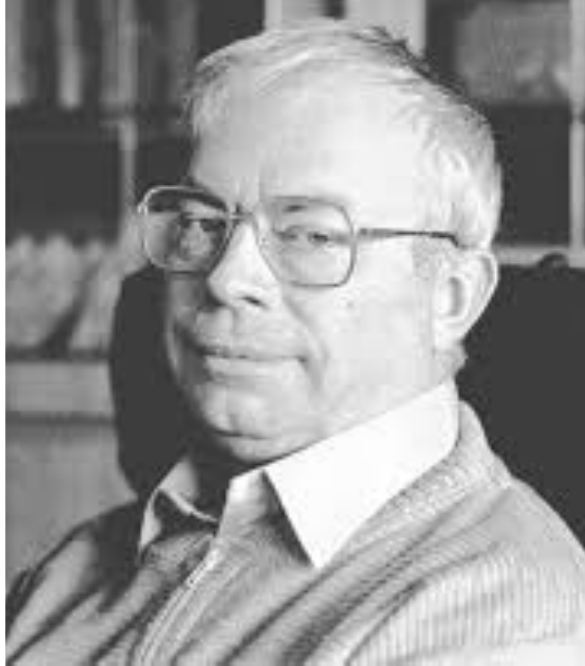
Figure 2 | Georg Nees